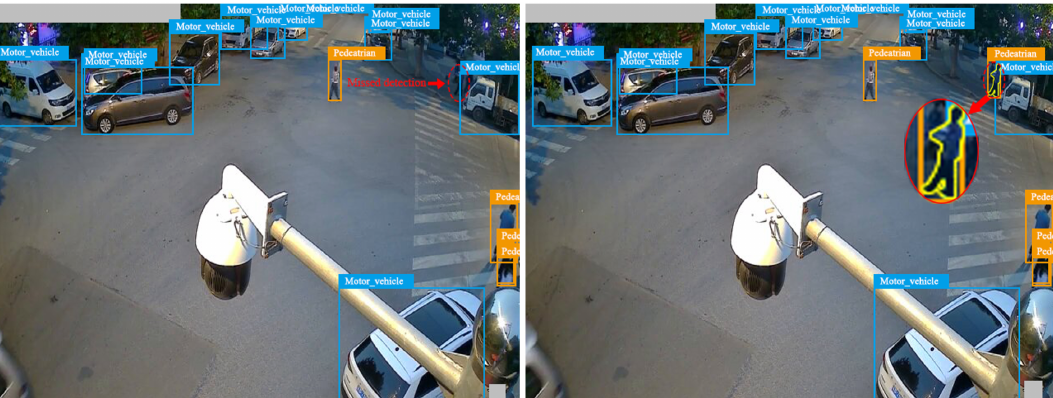
Figure 12. A set of label images obtained by detecting the test set with YOLOv5s and the suggested model, respectively. For the same image, YOLOv5s fails to detect the pedestrian in the shadow (small objection), but our proposed model correctly assigns the label to the objection (pedestrian).